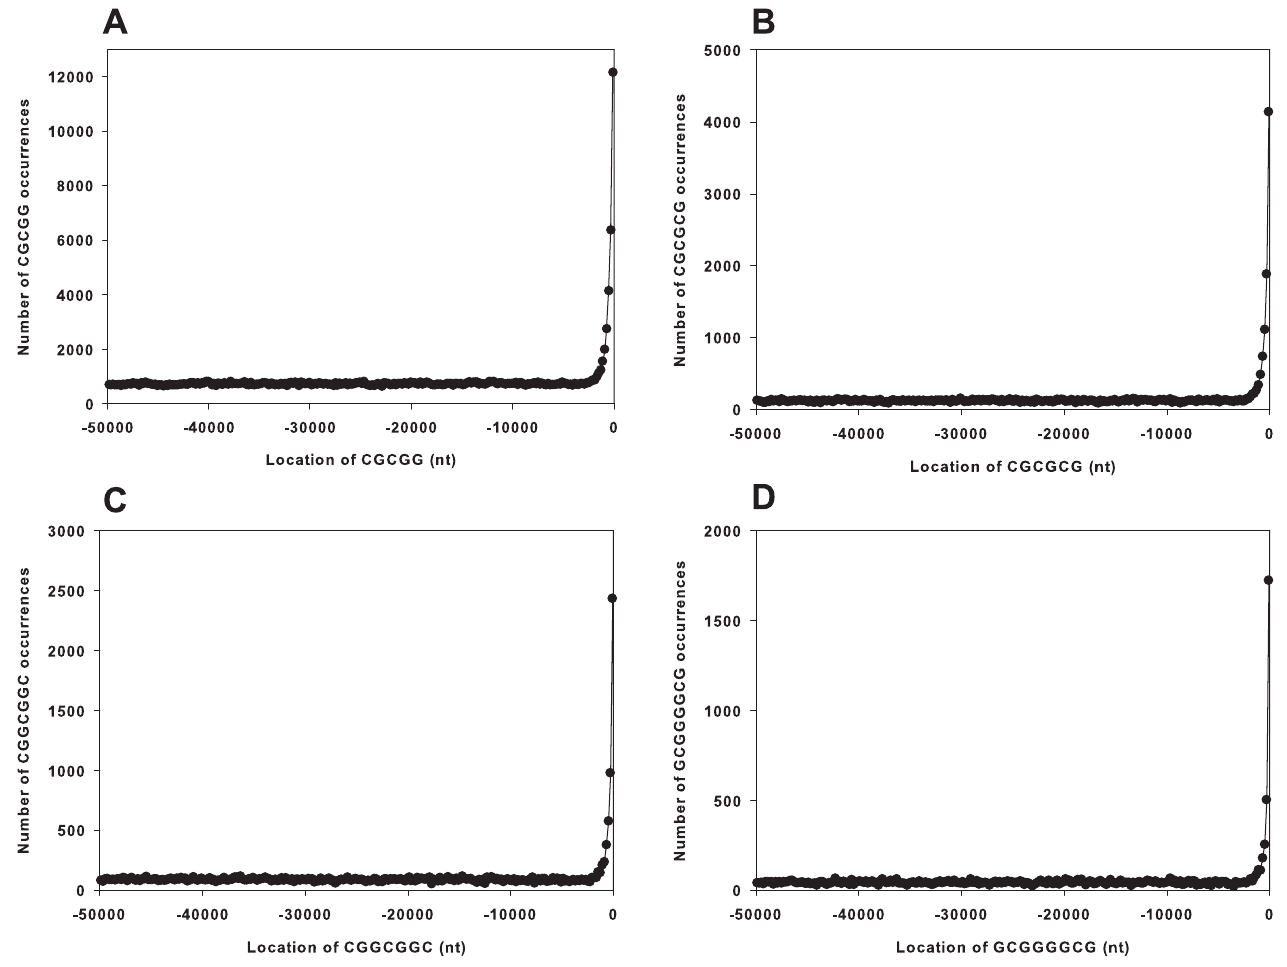
Figure 2. Overrepresented k-mers in Upstream miRNA Sequences Are Preferentially Located towards the Genomic Loci of Protein-Coding Genes Representative motifs show strong bias to occur near the genomic loci of protein-coding genes. The number of occurrences of CGCGG (A), CGCGCG (B), CGGCGGC (C), and GCGGGGCG (D) motifs are plotted at 200-nt intervals in the upstream regions (50 kb) of protein-coding genes. The number of occurrences of the motif in each 200-nt bin significantly increases towards the first 1,000 nt that are directly upstream of the protein-coding genes ( (cid:3) 1,000 to 0 nt